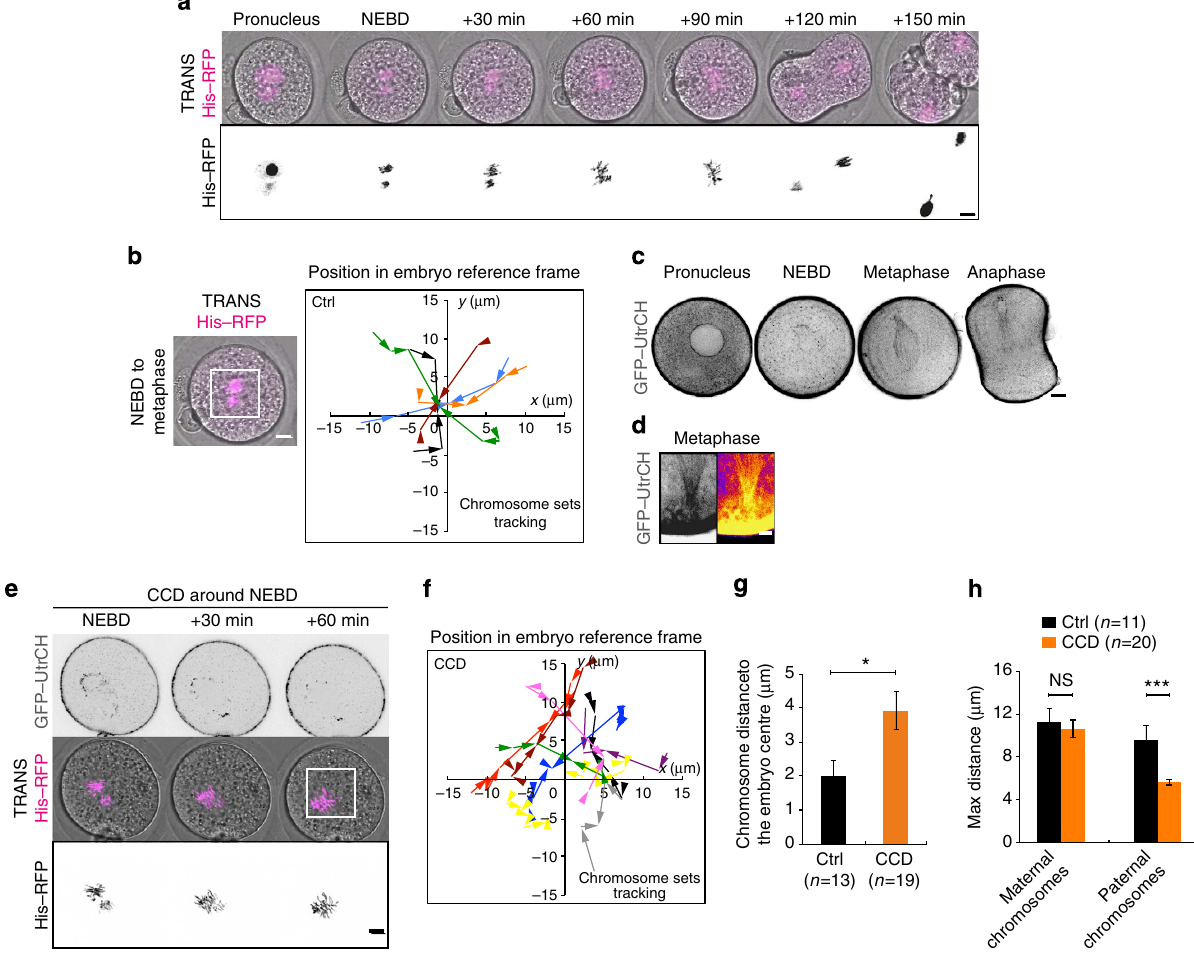
Figure 3 | Fine chromosome centring in mitosis is actin dependent. ( a ) Control embryo expressing His–RFP (purple or black, Z-projection over 20 m m). Scale bar, 10 m m. ( b ) Left panel: Control embryo expressing His–RFP (purple, Z-projection over 20 m m) during chromosome migration. Scale bar, 10 m m. Right panel: graph showing the position of the centroid of the two sets of chromosomes in the referential of the embryo (0 being the centre) from NEBD to metaphase for controls. The scale is represented by the white box on the left panel. Each colour represents an embryo. The arrows point to the position where the chromosomes merge. One time point every 15 or 20min over 1h. ( c ) Embryo expressing GFP–UtrCH (black). One Z-plane is shown every 40min. Scale bar, 10 m m. ( d ) Metaphase embryo expressing GFP–UtrCH (left: black. Right: white, higher intensity and black, lower intensity). Zoom on the connection between the actin cage and the cortex (cortex saturated to allow visualization of the actin cage filaments). Scale bar, 5 m m. ( e ) Embryo treated with 1 m gml (cid:2) 1 Cytochalasin D (CCD) around NEBD expressing GFP–UtrCH (black, one Z-plane is shown) and His–RFP (purple or black, Z-projection over 20 m m). Scale bar, 10 m m. ( f ) Same as b for embryos treated with CCD around NEBD. ( g ) Bar graph showing the position of the centroid of the merged chromosomes for controls (black bar) and embryos treated with CCD around NEBD (orange bar). Mean is shown of 13 controls and 19 CCD embryos. s.e.m. is plotted on each bar. Statistical significance of differences is assessed with a Mann–Whitney test ( P value 0.0175). ( h ) Graph showing the maximum distance (that is, the distance between the points furthest apart on the trajectories) of chromosome motion in controls (black bars, from Supplementary Fig. 1c) and embryos treated CCD around NEBD (orange bars) during the migration of the two sets of chromosomes towards the embryo centre. Mean of 11 controls and 20 CCD embryos are shown over 3 independent experiments. s.e.m. is plotted on each bar. Statistical significance of differences is assessed with t -test or Mann–Whitney tests ( P values: female 0.6776; male